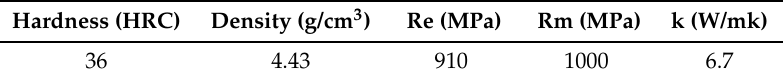
Table 2. Physical properties of